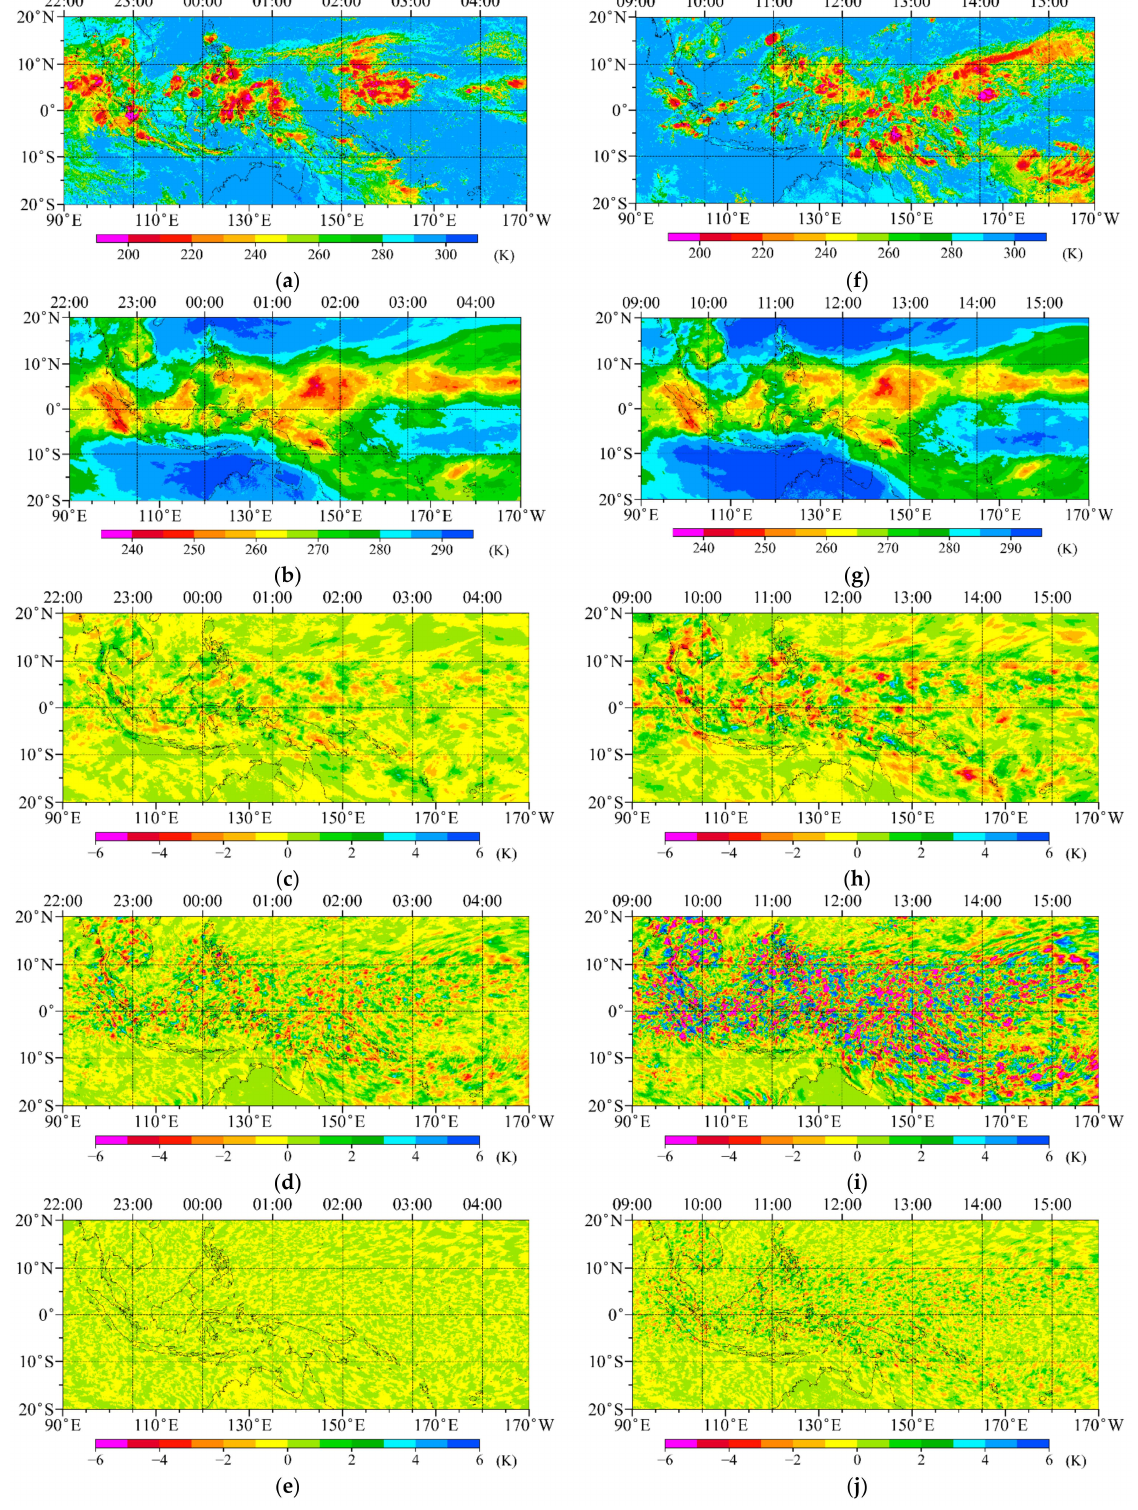
Figure 9. ( a , f ) The AHI observations of brightness temperature, ( b , g ) the first, ( c , h ) the 20th, ( d , i ) the 40th, and ( e , j ) the 60th PCA components ( panels) and 0300 UTC 11 May 2021 ( right panels). The local time at the corresponding longitude is indicated at the top of the